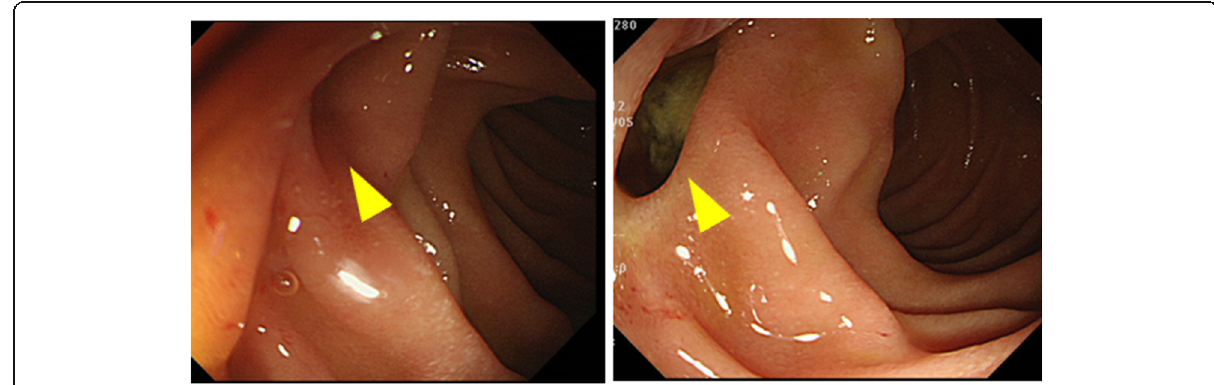
Fig. 3 Upper gastrointestinal endoscopy performed 2 months after surgery revealed the presence of food debris in the duodenal diverticulum (yellow